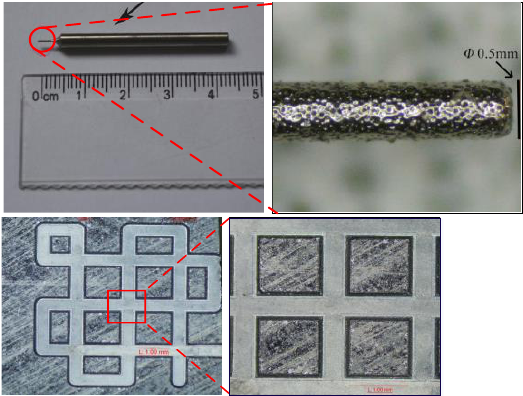
Figure 24. Structure diagram of micro-grinding rod.